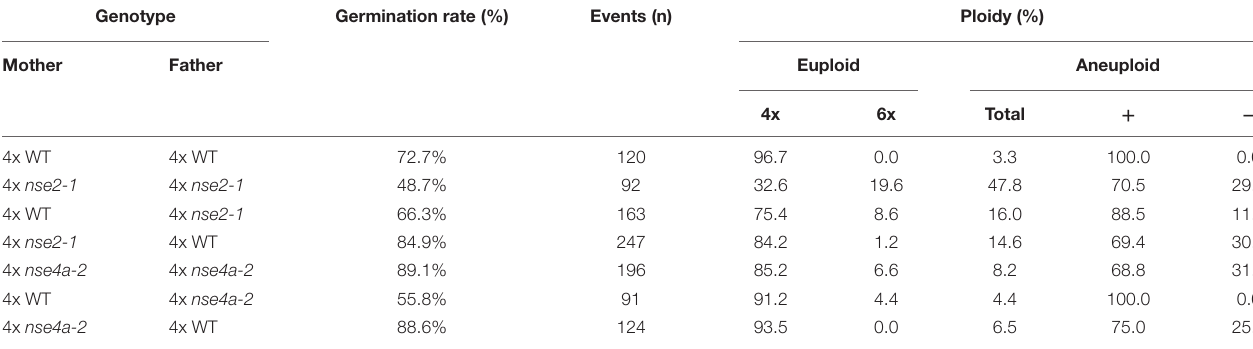
TABLE 2 | Flow cytometry-based ploidy levels of F1 offspring plants from tetraploid (4x) WT, nse2-1 , and nse4a-2 parents.